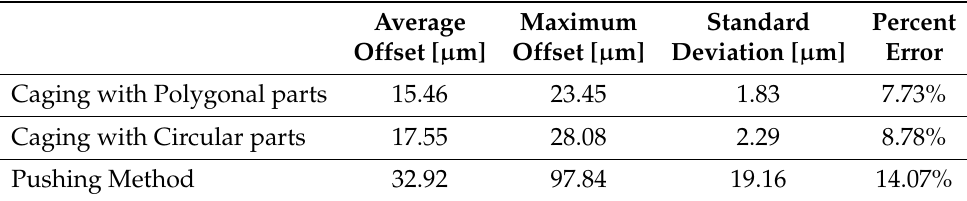
Table 2. Accuracy tests comparison for caging versus pushing